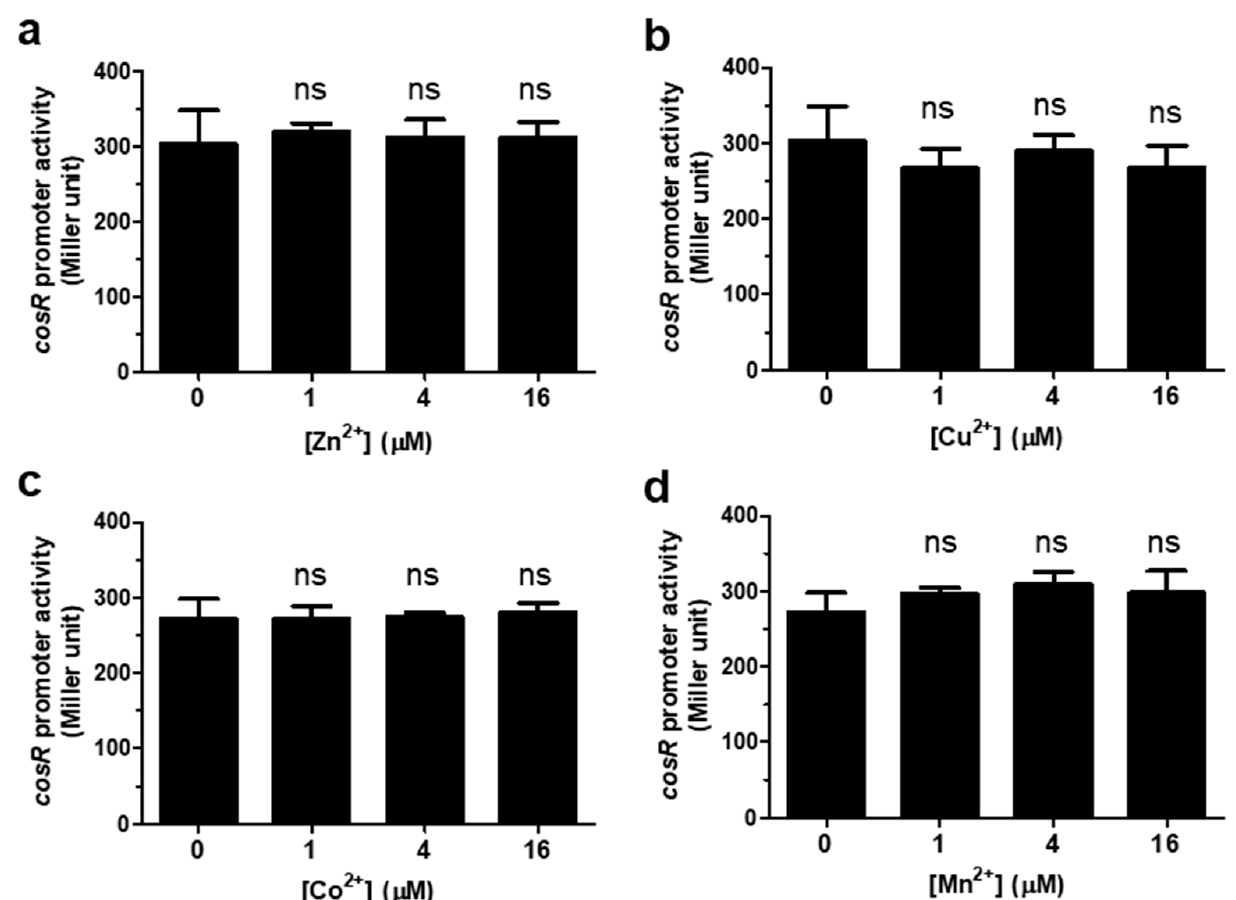
Figure 2. Irresponsiveness of cosR transcription to divalent metal ions other than iron. The P cosR :: lacZ fusion assay was conducted with Zn 2+ ( a ), Cu 2+ ( b ), Co 2+ ( c ), and Mn 2+ ( d ). The results show the means and standard deviations of three samples in a single experiment. The experiment was repeated three times, and similar results were obtained in the repeated experiments. The statistical analysis was performed using Student’s t -test in comparison with the control without ions. ns: not significant.